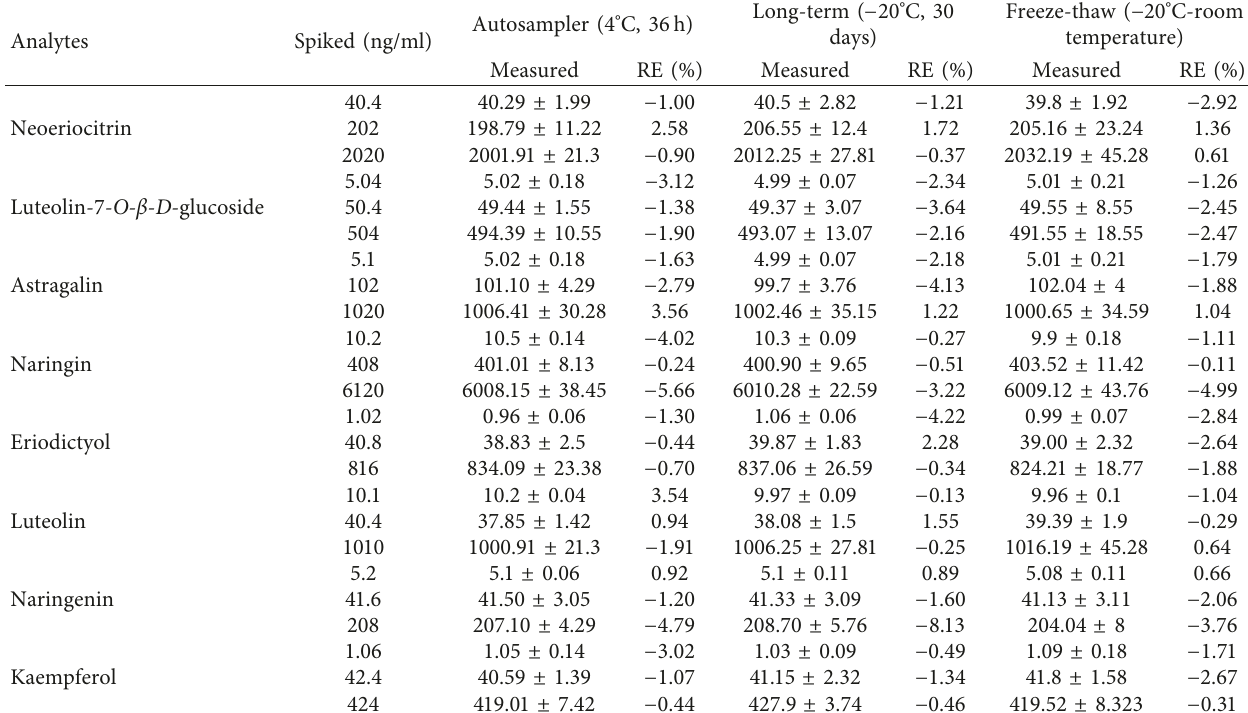
Table 5: Stability evaluation results ( n �